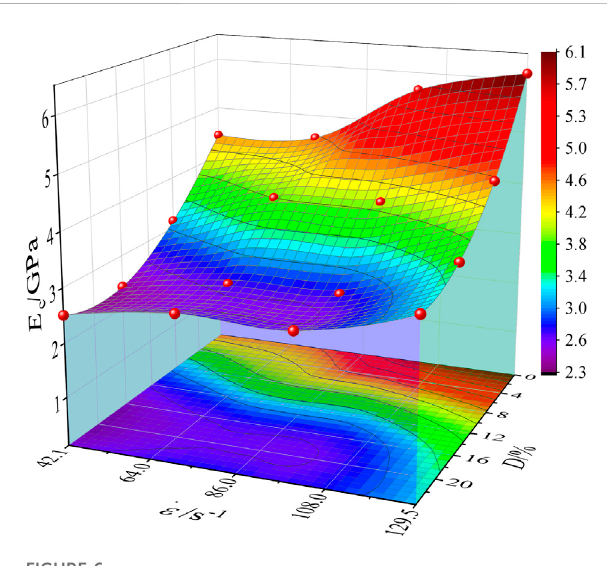
FIGURE 6 Coupling effect of initial damage and strain rate on dynamic elasticity